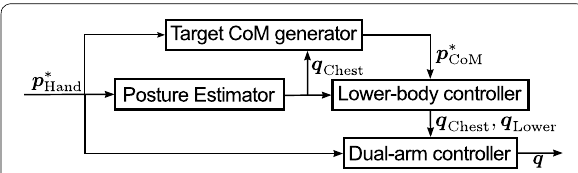
Fig. 6 The data flow in both the posture estimator and the whole- body controller (the target CoM generator, the posture estimator,